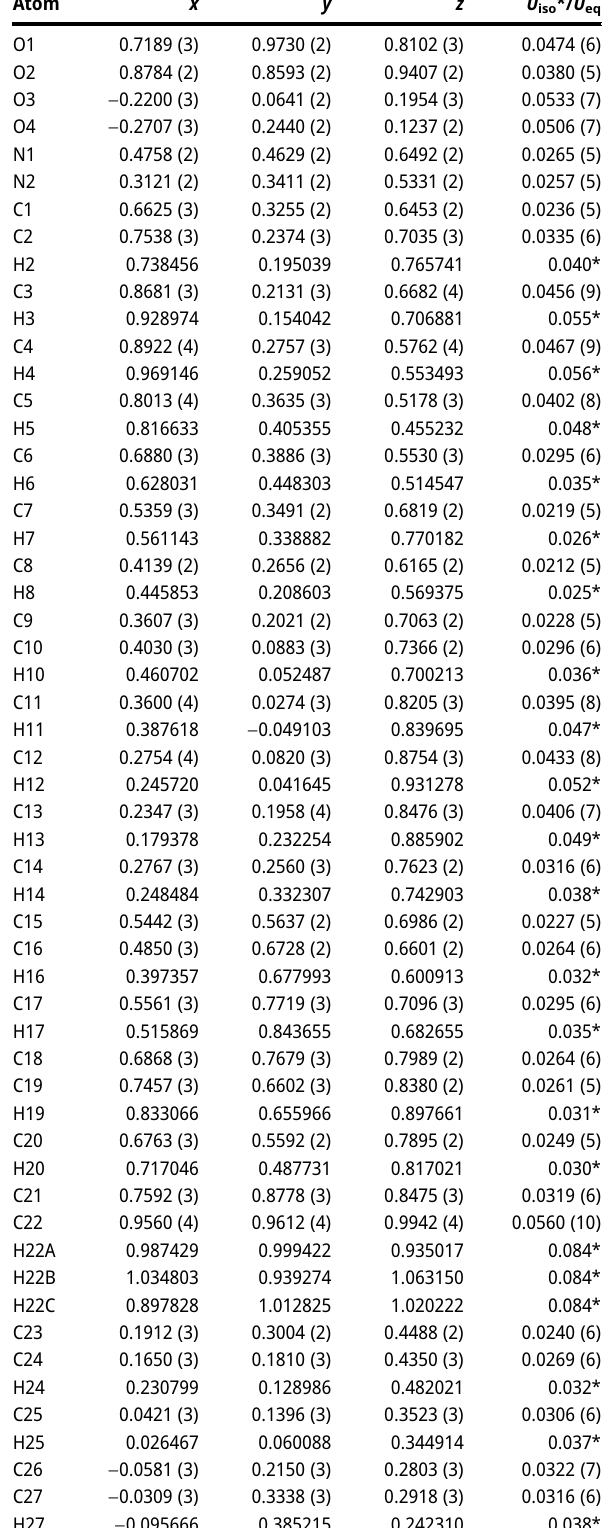
Table  : Fractional atomic coordinates and isotropic or equivalent isotropic displacement parameters (Å 